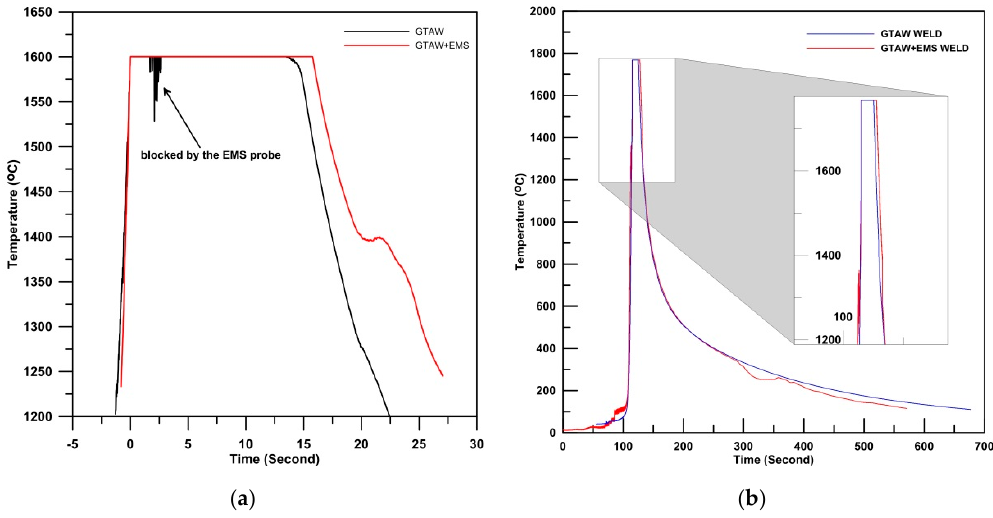
Figure 9. The temperature profiles of welds: ( a ) high-speed pyrometer and ( b ) R-type thermocouple.